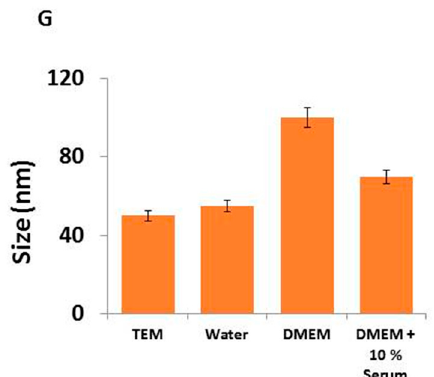
Figure 1. Synthesis and characterization of silver nanoparticles (AgNPs). ( A ) Ultraviolet-visible spectra of AgNPs; ( B ) X-ray diffraction pattern of AgNPs; ( C ) Fourier-transform infrared spectroscopy (FTIR) spectra of AgNP; ( D ) size distribution analysis of AgNPs using dynamic light scattering (DLS); ( E ) transmission electron microscopy (TEM) images of AgNPs; ( F ) histogram of the particle sizes from TEM images; ( G ) characterization of size distribution of AgNPs in different dispersion media.